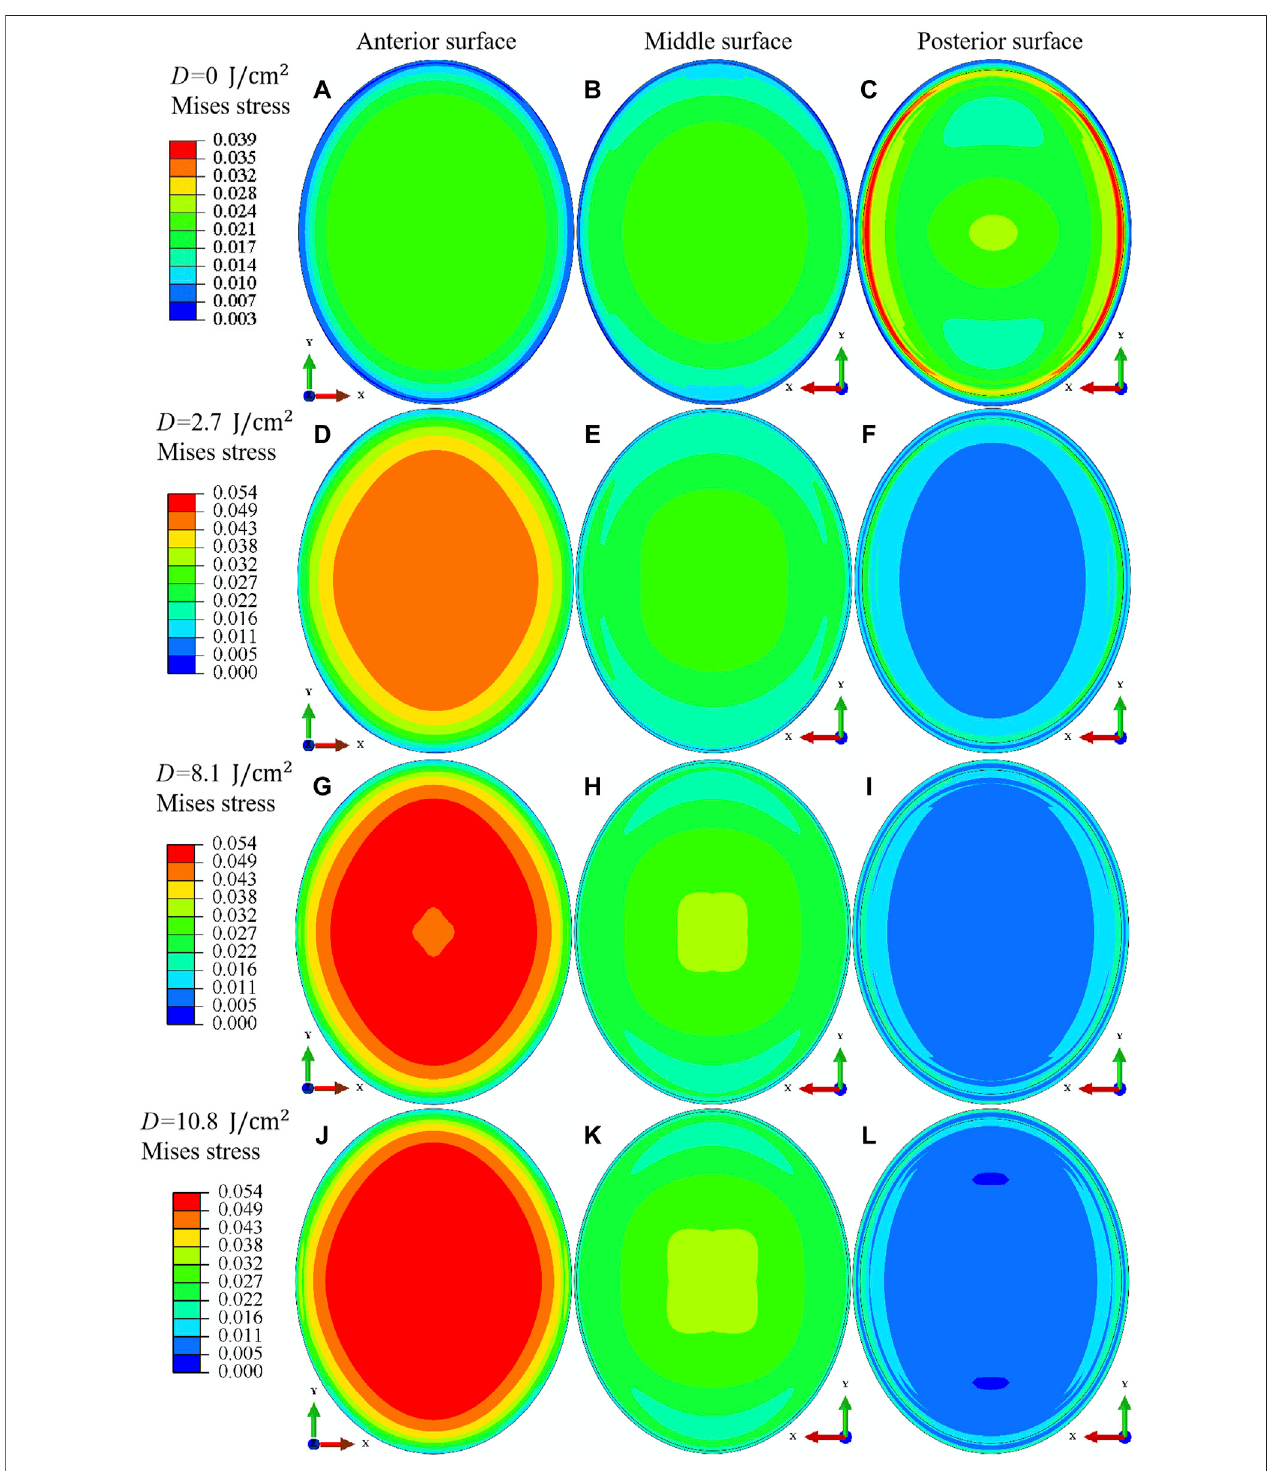
FIGURE7| Comparison oftheMises stress(unitinMPa) distribution fortheanterior surface (A,D,G,J) ,middlesurface (B,E,H,K) and posteriorsurface (C,F,I,L) of porcine cornea when the IOP equals 30 mmHg. The irradiation dose increases from 0J/cm 2 to 10 . 8J/cm 2 .